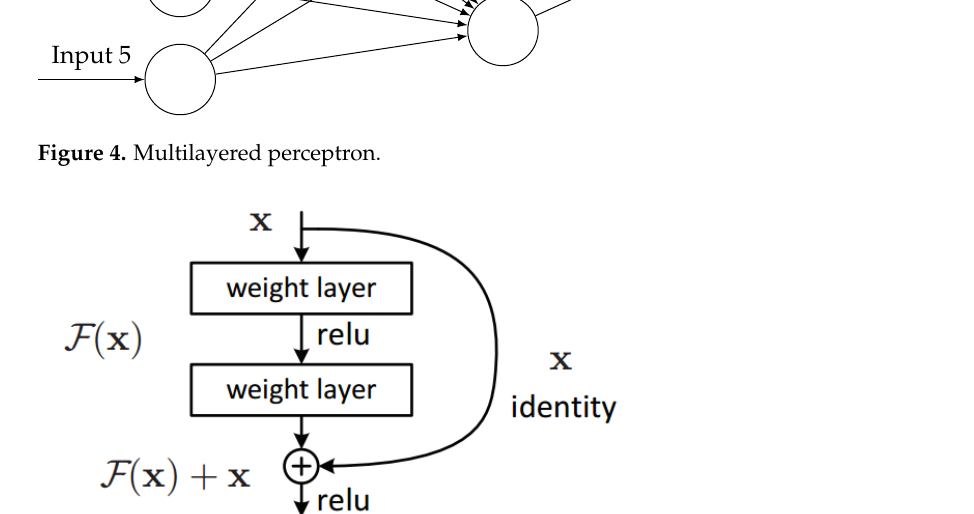
Figure 5. Residual block. Source, accessed on 22 September 2022 : https://miro.medium.com/max/713/